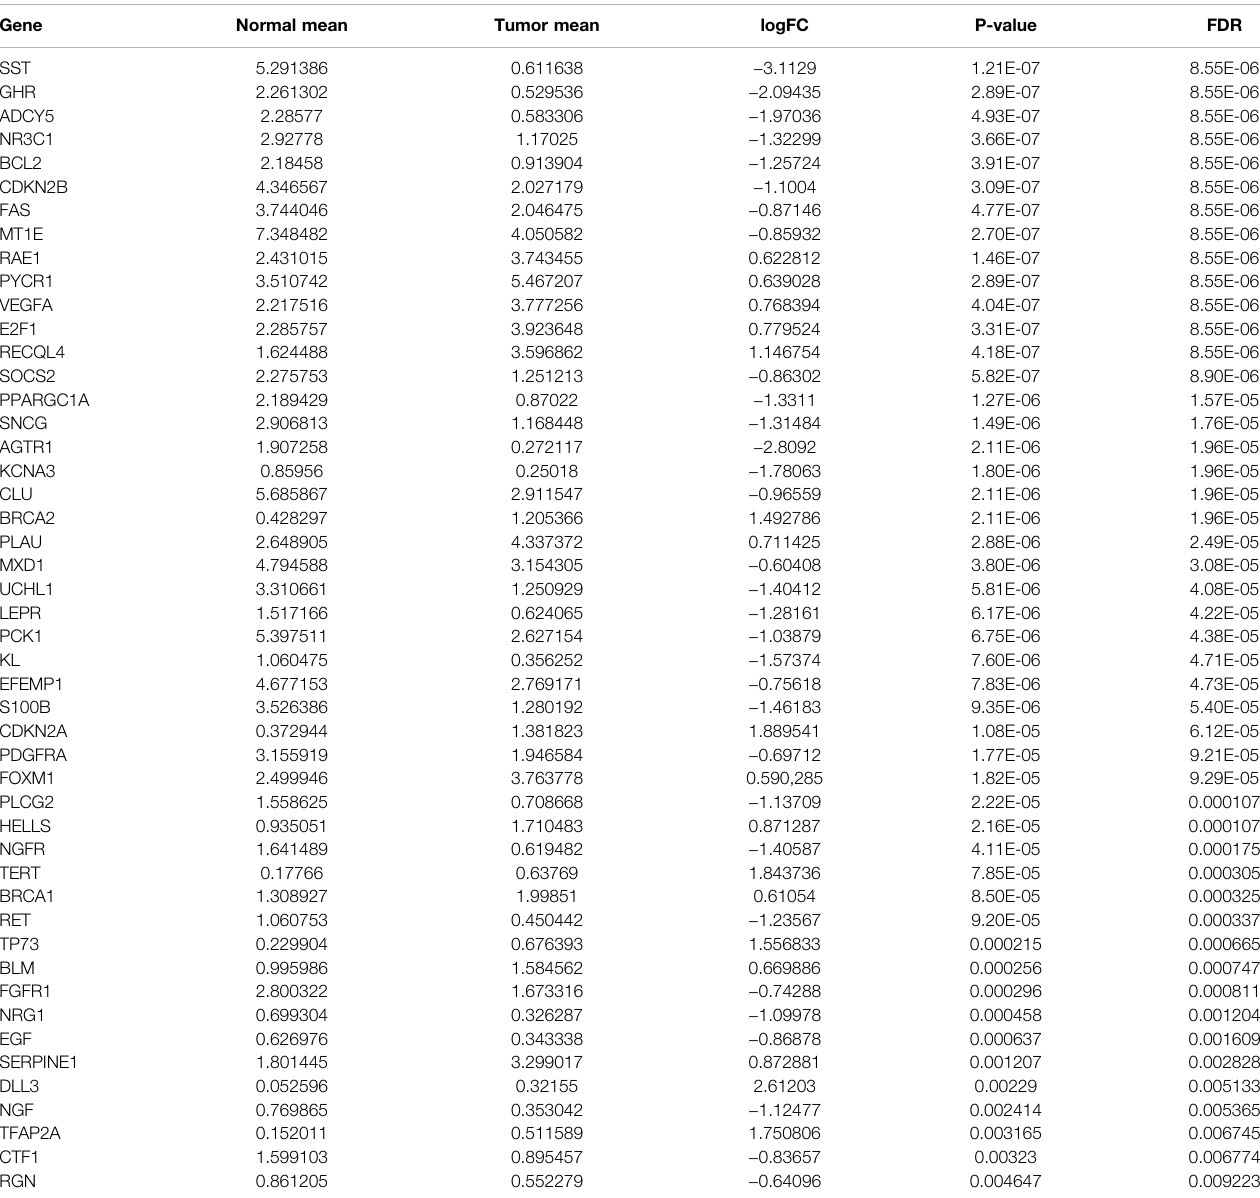
TABLE 1 | Differentially expressed aging-related genes in rectal cancer. Gene Normal mean Tumor mean logFC P-value